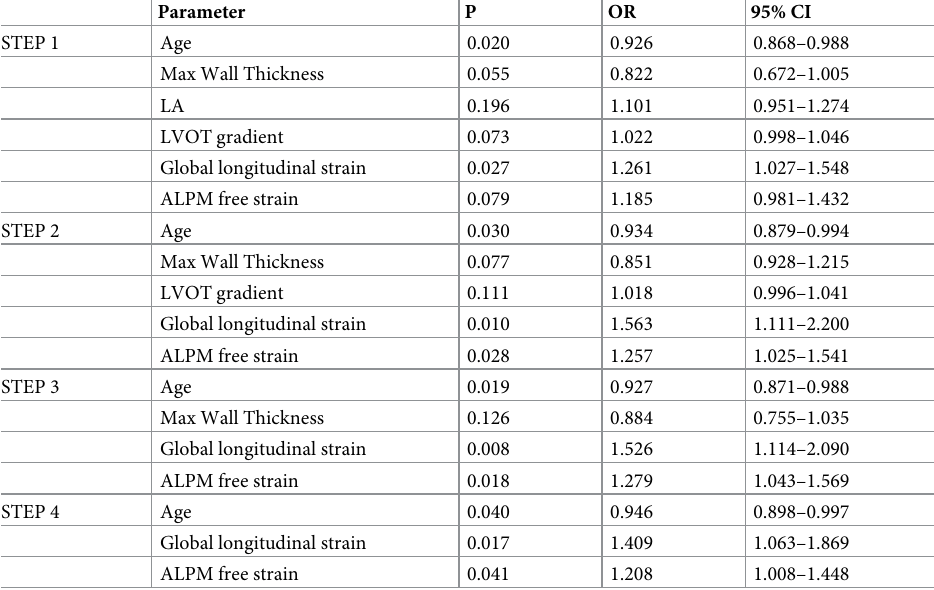
Table 3. Backward multivariate logistic regression for predictors of SCD.